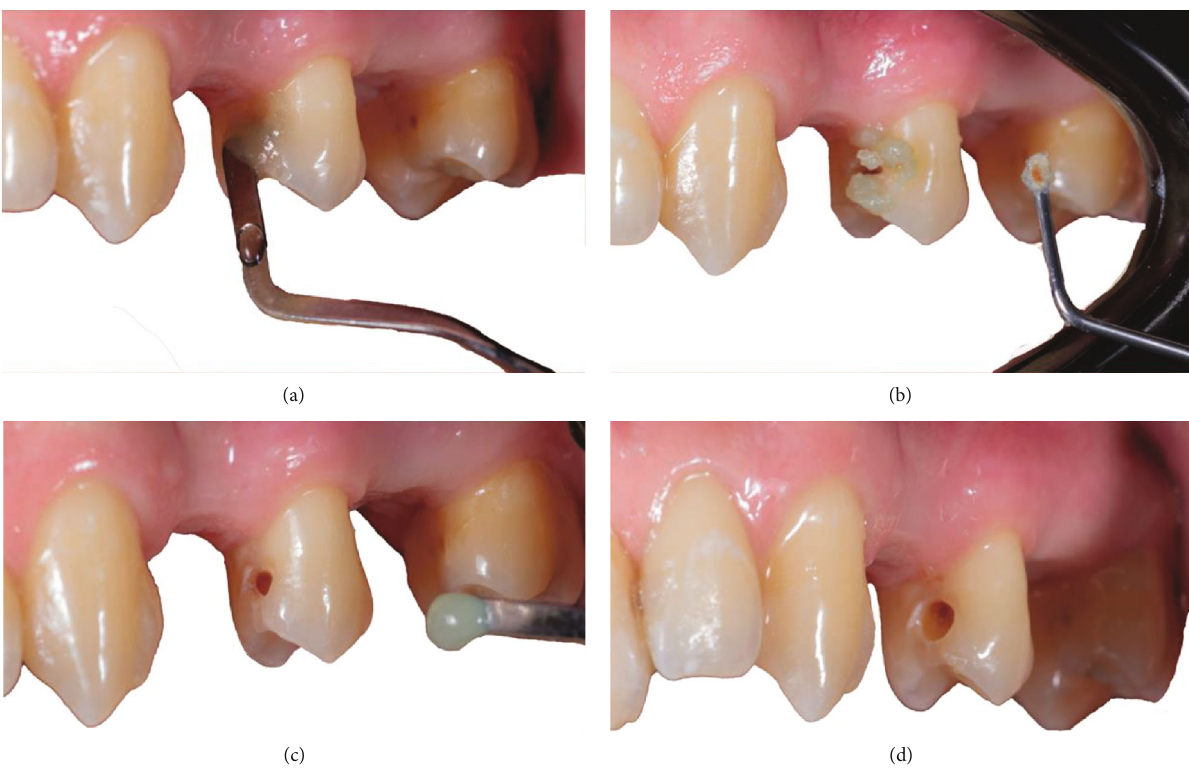
Figure 5: (a) Second application of BRIX3000. (b) The cavity during a second application. (c) Tooth after removing the altered tissue in the second phase. (d) Cavity at the end of the third application. Correction of the pro fi le was performed using the